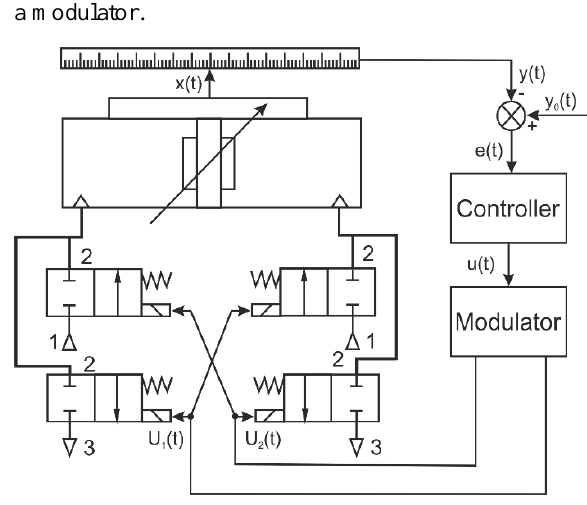
Fig. 2. Diagram of a drive with choking control with four 2/2 directional valves.